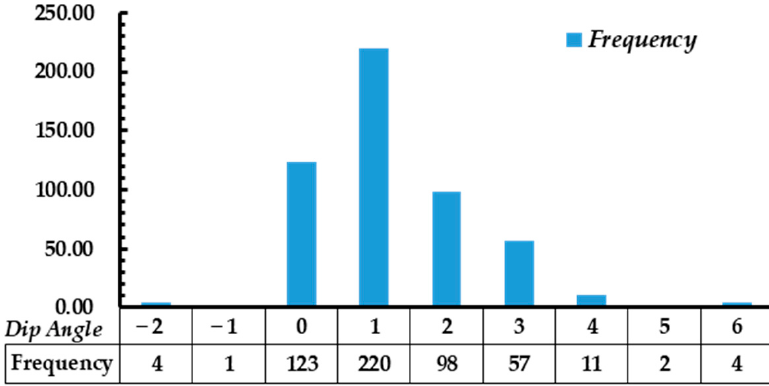
Figure 8. Frequency diagram of coal seam dip angle.